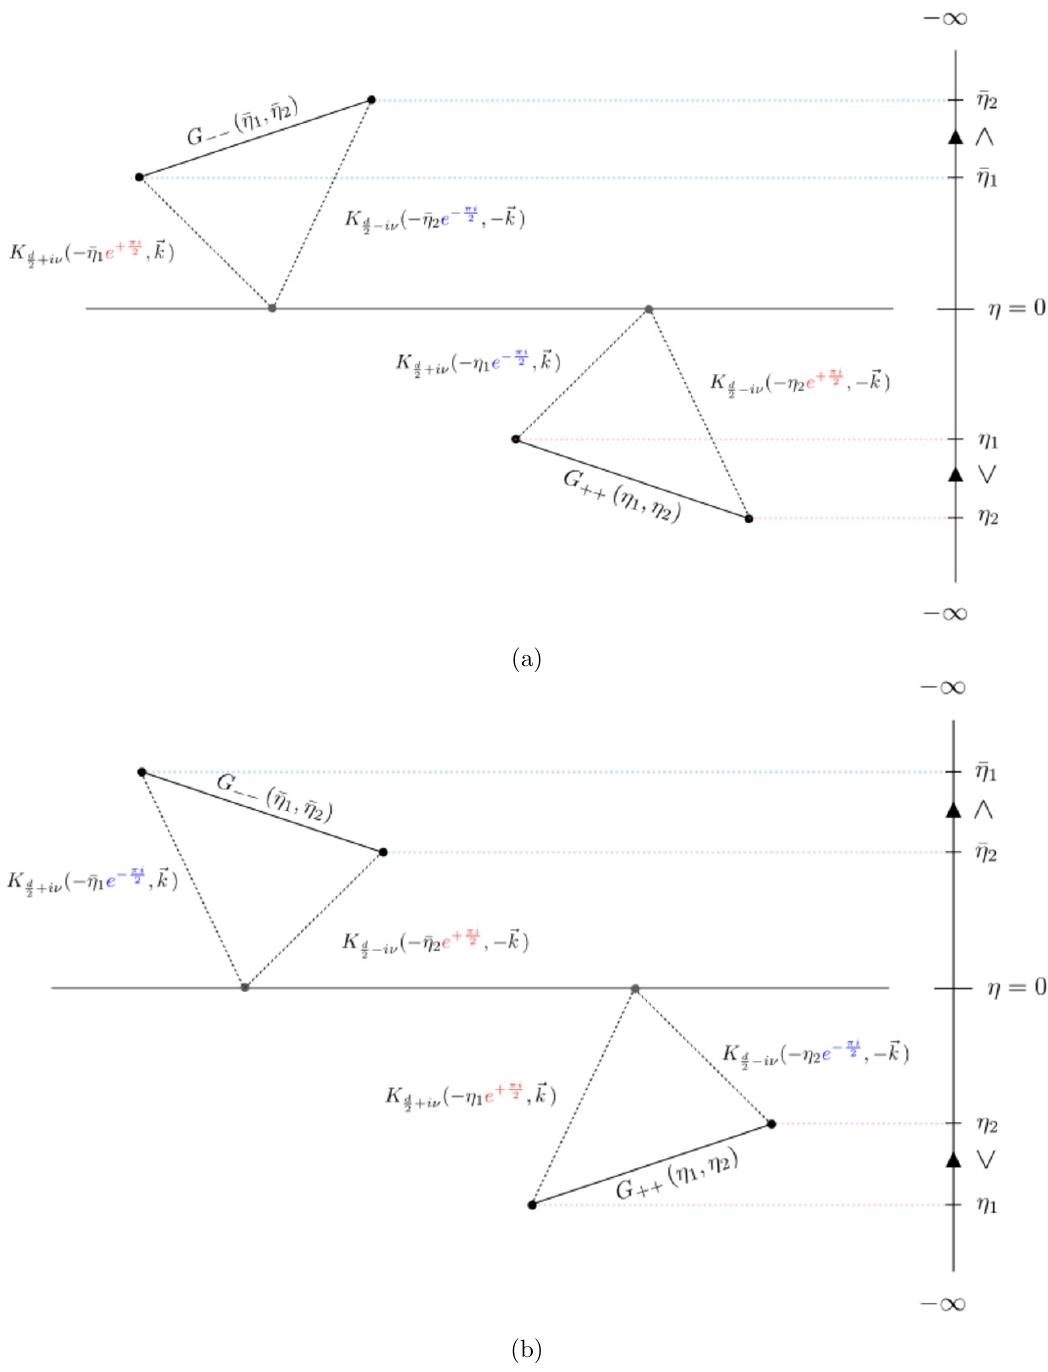
Figure 2. Depiction of the split representation for de Sitter propagators on the ++ and (cid:0)(cid:0) branches of the in-in contour, for (cid:17) 1 > (cid:17) 2 , (cid:22) (cid:17) 1 > (cid:22) (cid:17) 2 ((cid:12)gure (a)) and (cid:17) 2 > (cid:17) 1 , (cid:22) (cid:17) 2 > (cid:22) (cid:17) 1 ((cid:12)gure (b)). The arrows along the vertical axis indicate the path along the in-in contour.